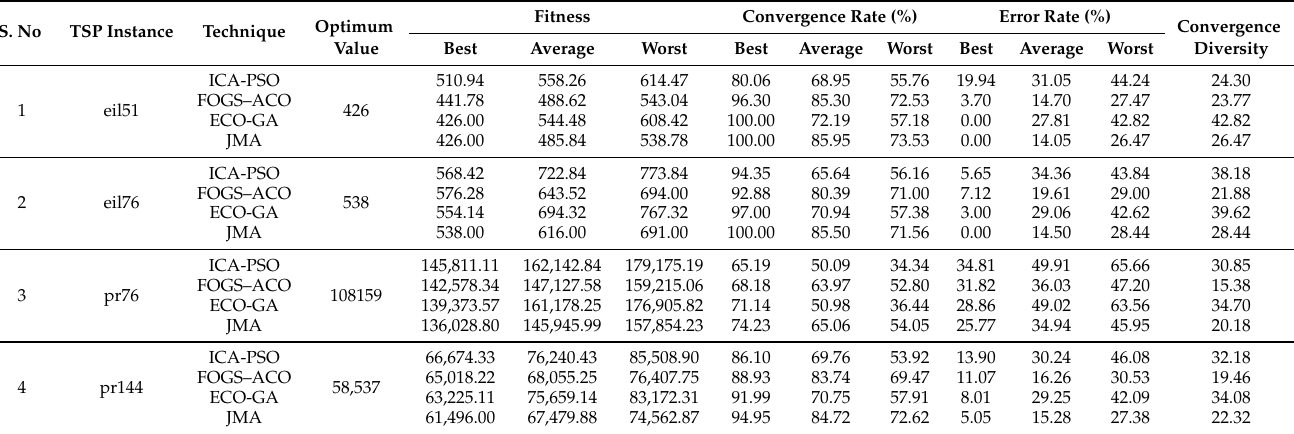
Table 9. Small-scale TSP